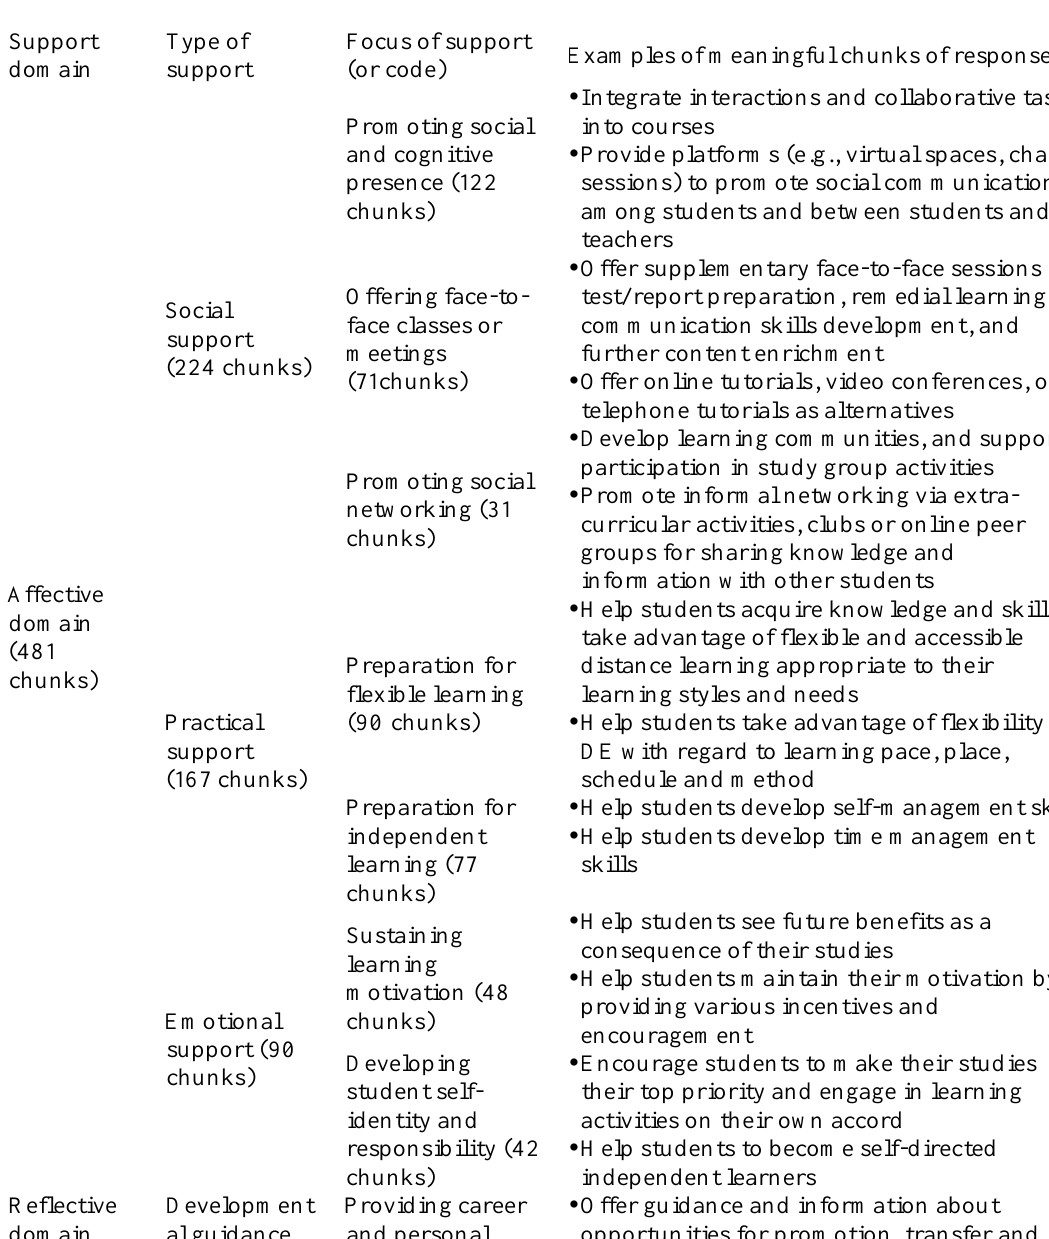
Coding and Categorization of Support Services Perceived Important for Quality DE by Asian Distance